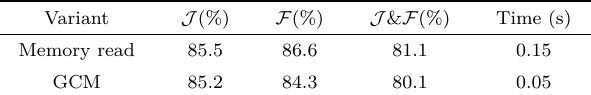
Table 2 Accuracy and speed of models using STM and GCM on the DAVIS 2017 dataset Variant